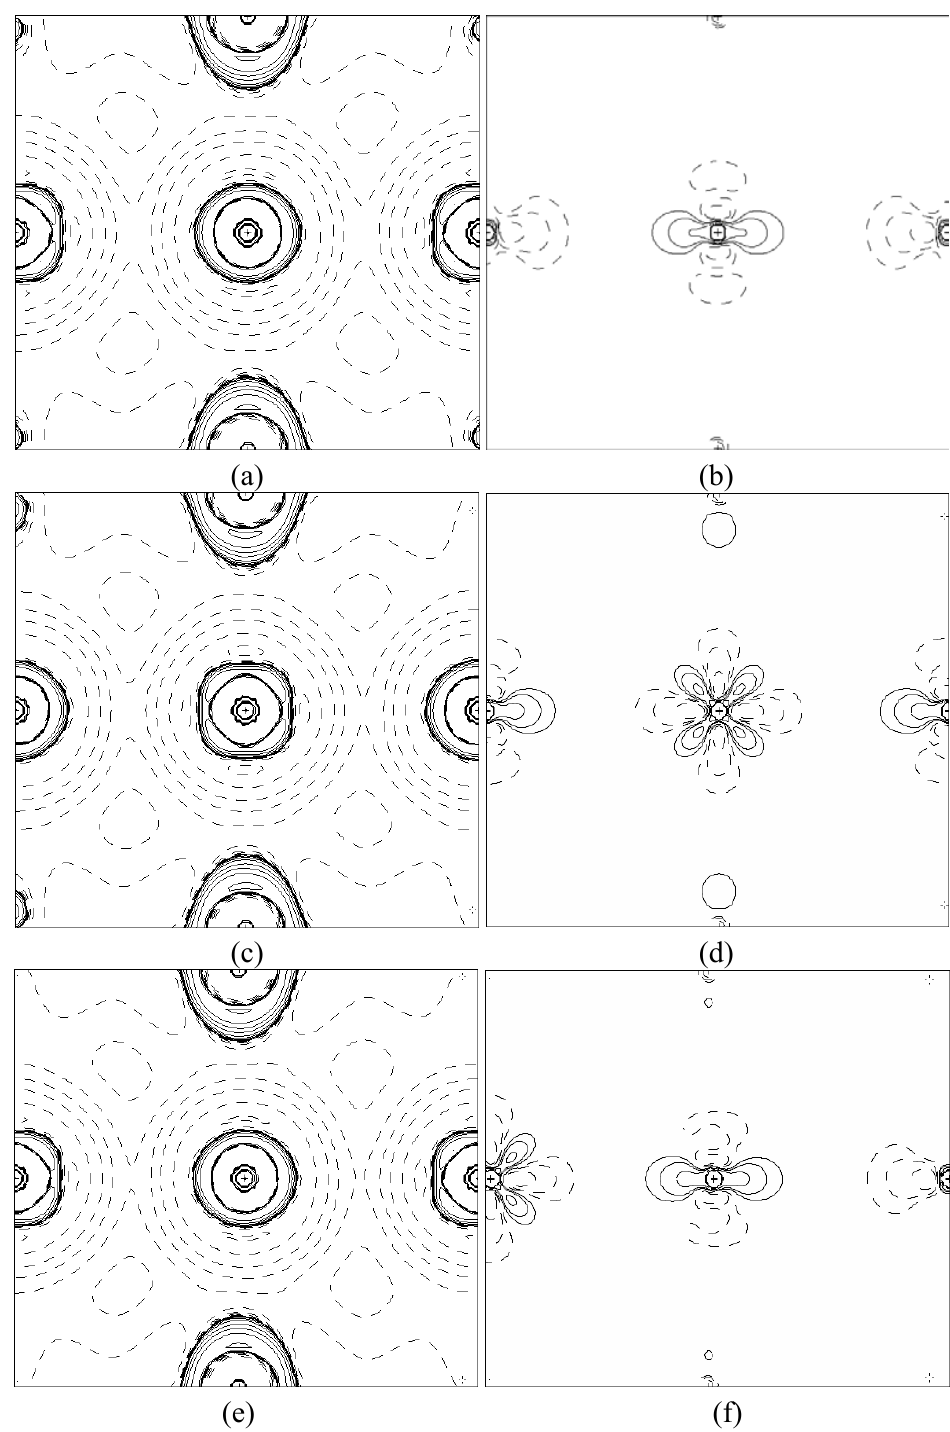
. (a), (c) and (e) are contour 7